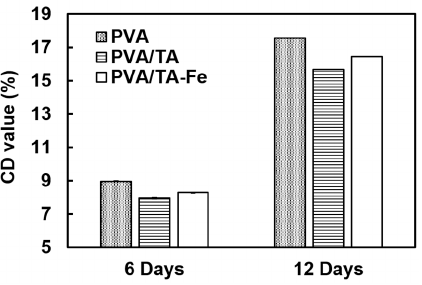
Figure 6. Antioxidant activity of fiber mats prepared with 8 wt % PVA concentration in sunflower oil.